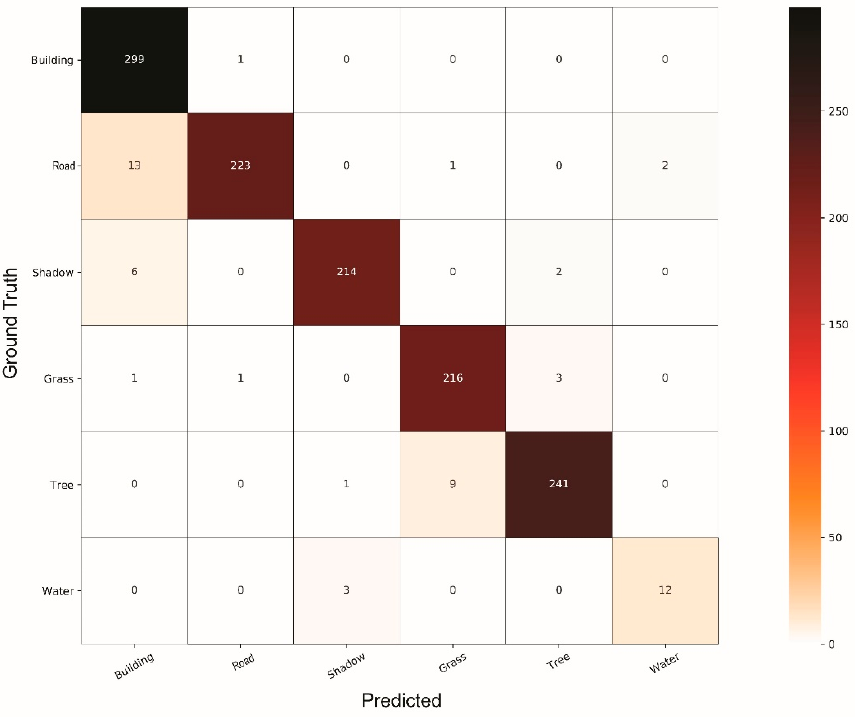
Figure A4. Confusion matrix derived from the MLP model for 30 cm image.